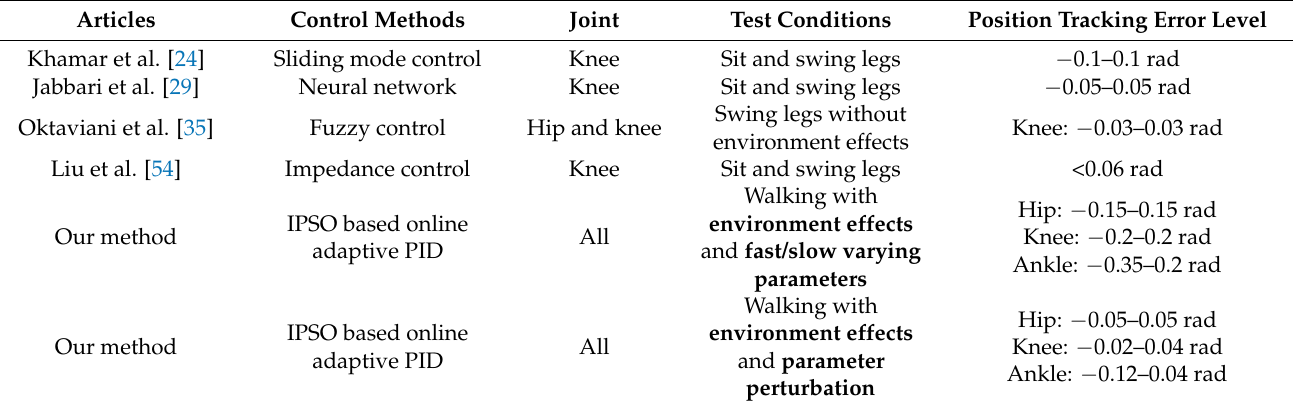
Table 1. Tracking accuracy of different